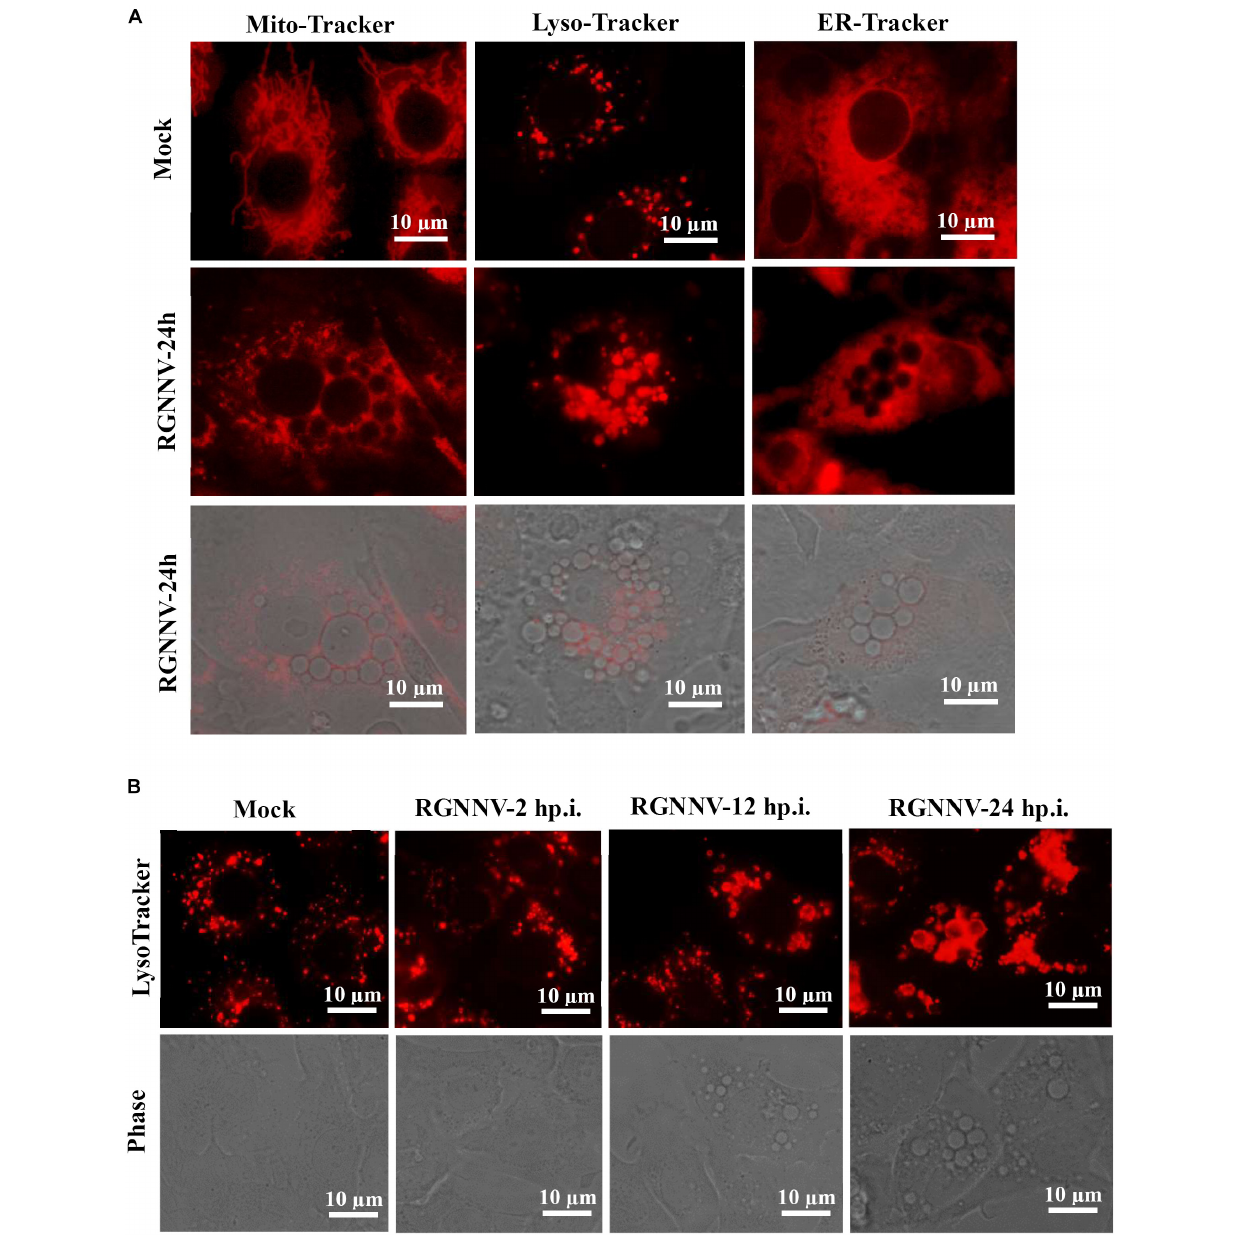
FIGURE 3 | The RGNNV infection-induced cytoplasmic vacuoles were derived from endosome/lysosome organelles. (A) The status of the lysosome, endoplasmic reticulum (ER), and mitochondria in vacuolated cells. Mock- or RGNNV-infected cells were stained with Mito-Tracker, Lyso-Tracker, or ER-Tracker, respectively, and then observed under an immunofluorescence microscope. (B) The morphology of the lysosome and vacuoles at different time points during RGNNV infection.